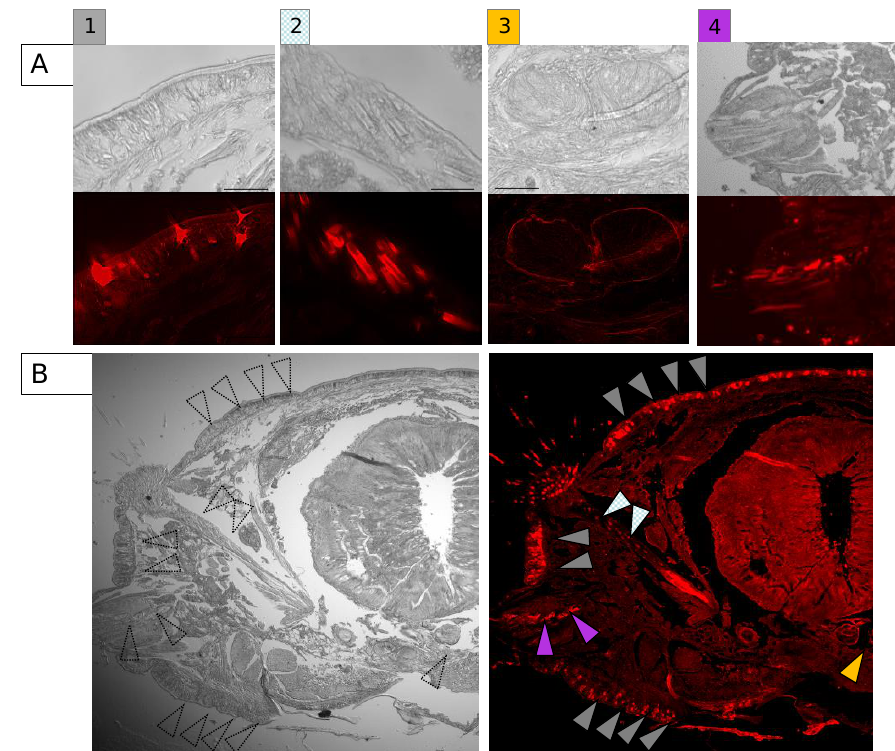
Figure 2. The tissues with PnL localization. ( A ) The epidermis ( 1 , gray), acicula ( 2 , meshed white), nerve cord ( 3 , orange), and nephridium ( 4 , purple). ( B ) The overview of the tissues. The colors of the arrows correspond to those in A. Scale bar: 50 μm.